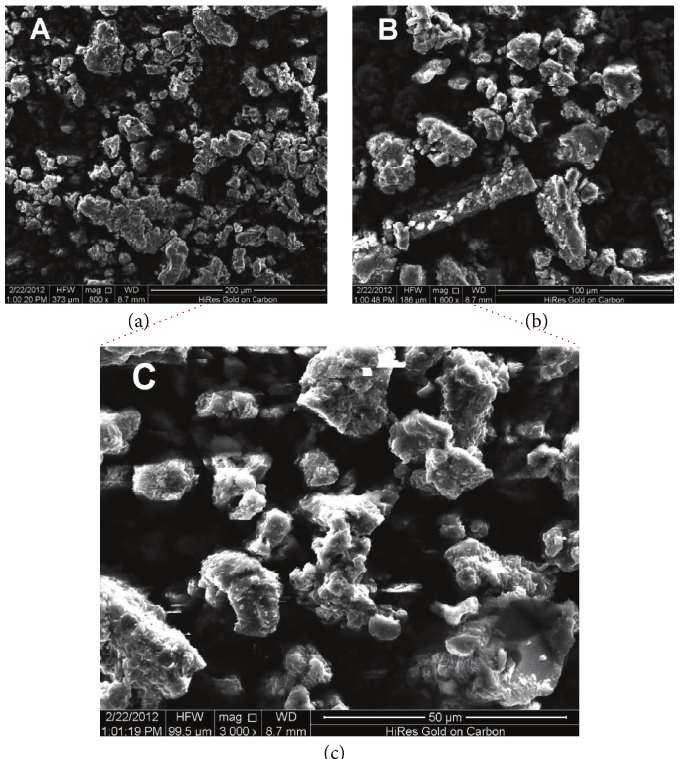
Figure 1: SEM of